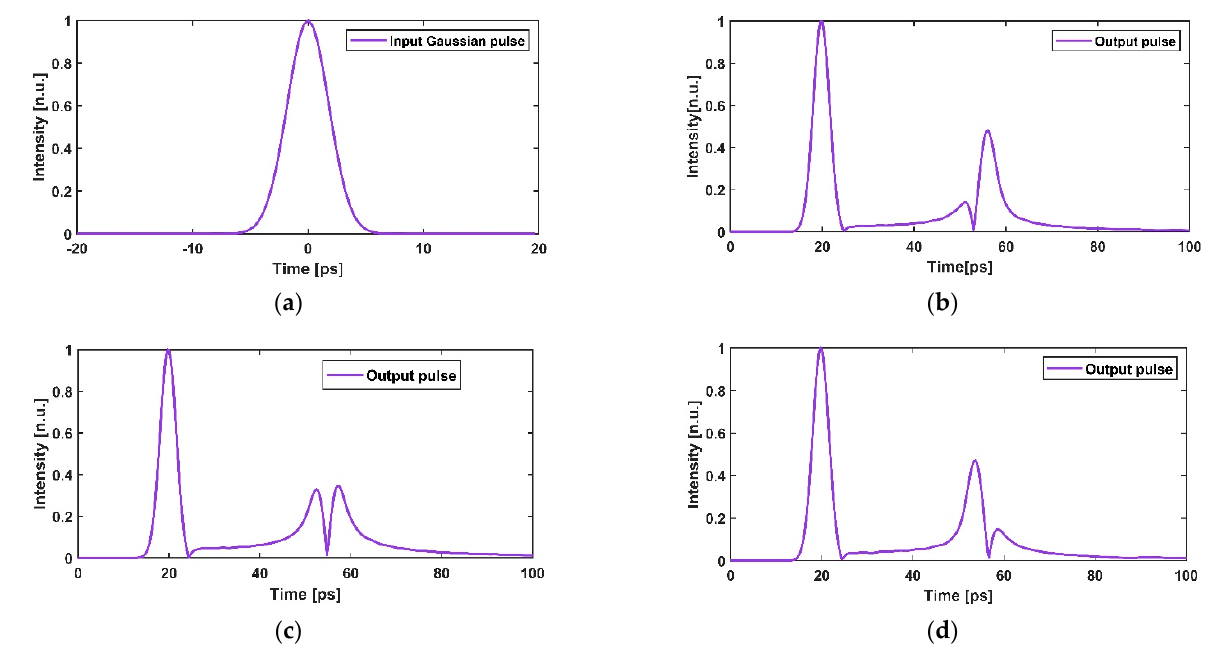
Figure 5. Temporal responses of the designed phase-modulated fiber Bragg gratings (PM-FBGs): ( a ) 3 ps-full-width at half-maximum (FWHM) input Gaussian pulse; output pulse of the designed ( b ) 0.5th-order PHT; ( c ) first-order PHT; and ( d ) 1.5th-order PHT.